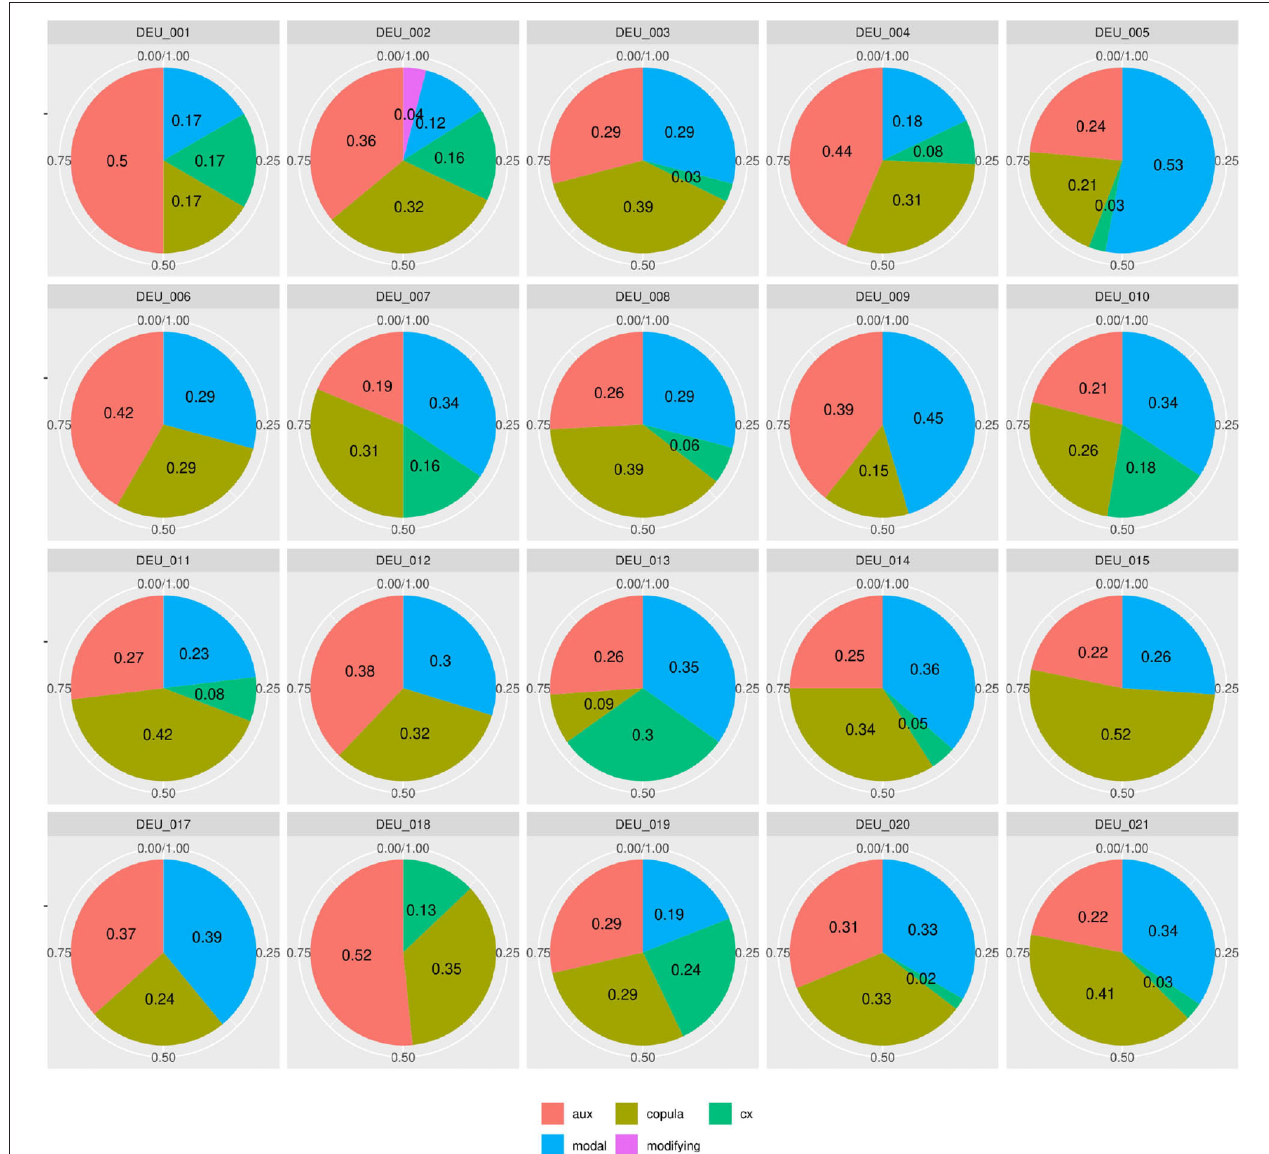
FIGURE 4 | Individual distributions of syntactic verb subclasses in the native speaker documents in Kobalt show striking differences in verb subclass proportions in spite of low degrees of lexical semantics present in the categorized verbs.